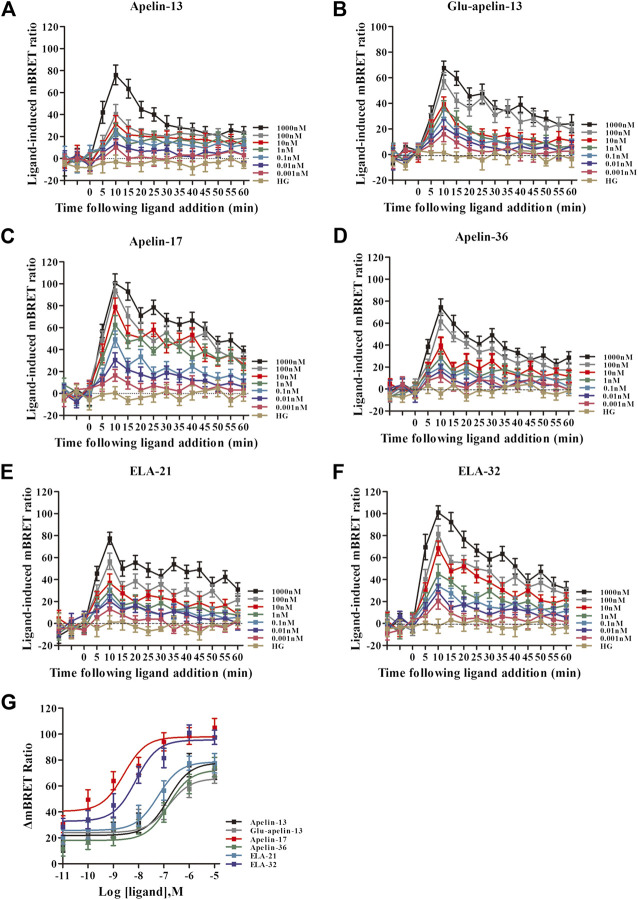
The time-response curve ((A–F) for GRK5) and dose-response curve ((G) for GRK5) of interactions between APJ and GRK5 induced by the six agonists of different concentrations, obtained from real-time dynamic BRET determination. p < 0.05 was considered as statistically significant. Control group (HG, Cells were stimulated with high glucose). With six peptides (G) stimulation, the dose-response curve of GRK5 recruited to APJ was measured by BRET (at 15 min). Data represent mean ± SEM from four independent experiments. Statistical analysis (Supplementary Table S4).